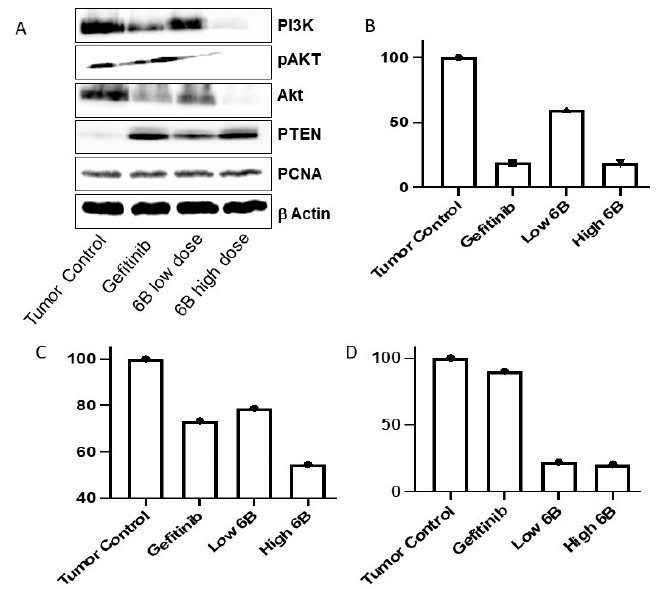
Figure 4. Immunoblotting ( A ) and qPCR analysis of Twist ( B ), Hif-1a ( C ), and Zeb-1 ( D ) in lung cancer tissues from treated and untreated mice. Gefitinib-treated mouse tumors were used as con- trols.